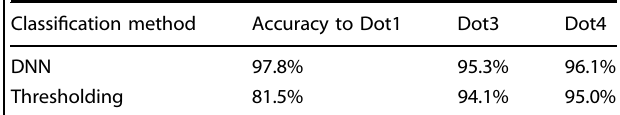
Table 1. Classi fi cation accuracy for DNN classi fi cation and thresholding for the experimental charge transition events. The threshold value was optimized to minimize the error. The SNR in Dot1, Dot3, and Dot4 were 7.41 dB, 13.5 dB, and 11.5 dB,